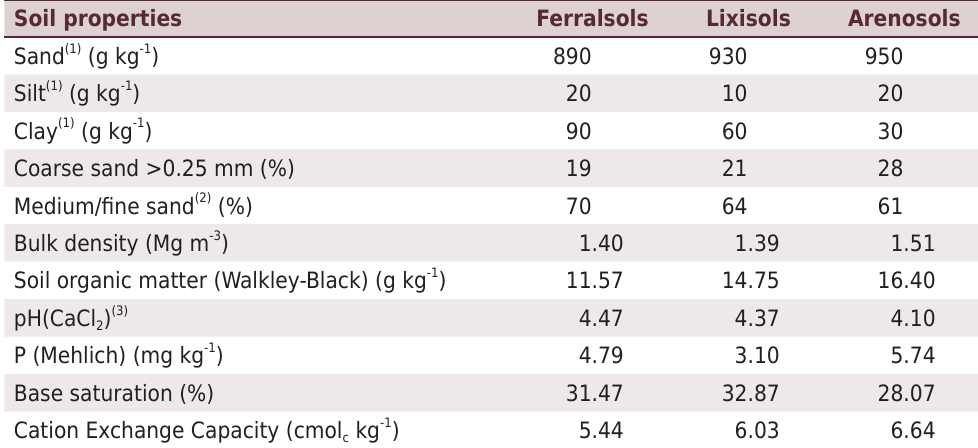
Table 1. Soils A horizon (0.00-0.20 m) properties along the catena Soil